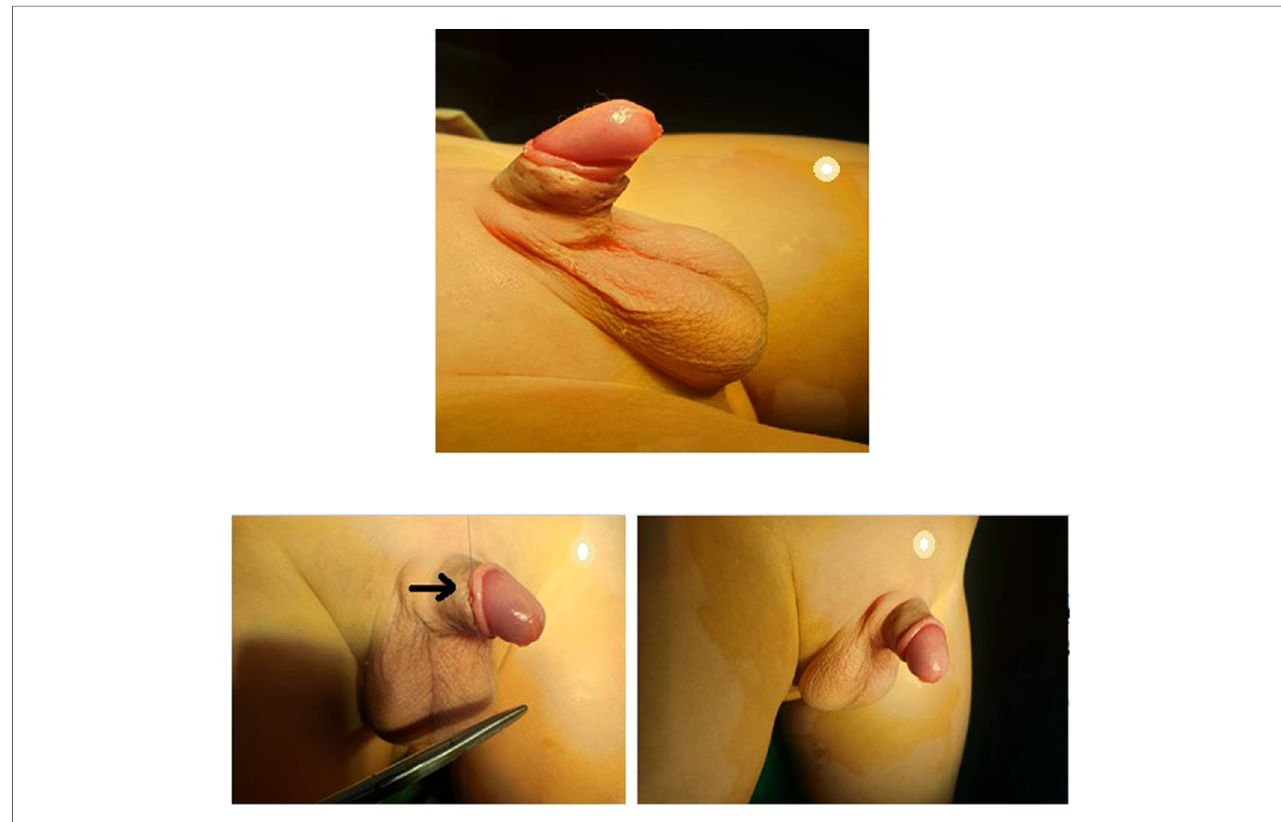
FIGURE 6 Suturing of the penile skin to the remaining mucosal collar using Vicryl 6/0 in a subcuticular fashion.